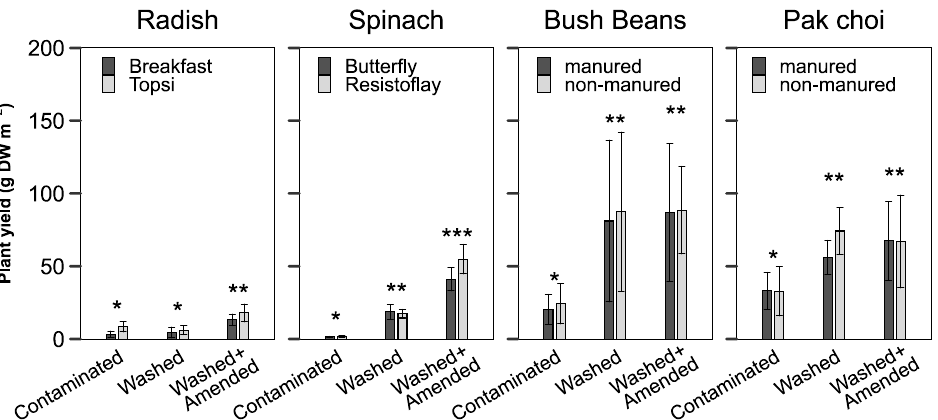
Figure 4. Yields of vegetables grown on contaminated and washed soils (mean ± SD, n = 4). For spinach and radish, two cultivars were compared. For pak choi and bush beans, two additional soil treatments were tested. Different number of asterisks indicates a significant difference between the soil treatments (Dunn test, p <